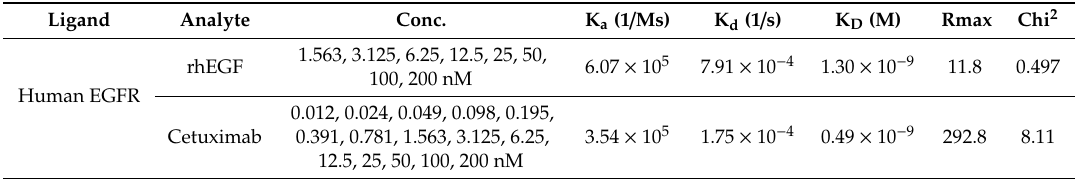
Table 1. rhEGF and cetuximab were compared in a surface plasmon resonance (SPR) analysis for their human EGFR binding, and approximate kinetic parameters are